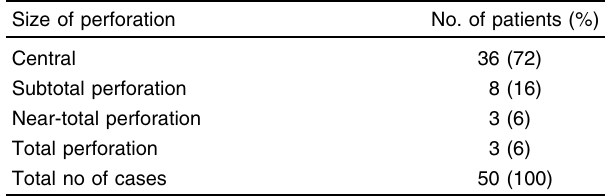
Table 4 Classification based on the size of the tympanic membrane